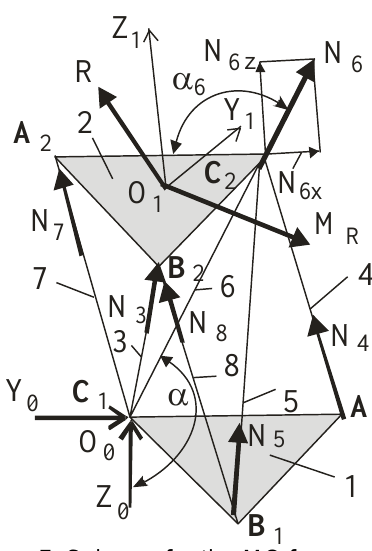
Figure 5. Scheme for the MC force analysis The obtained values of forces on the MC rod are used later in choosing pneumatic-hydraulic cylinders for the WPI design engineering.